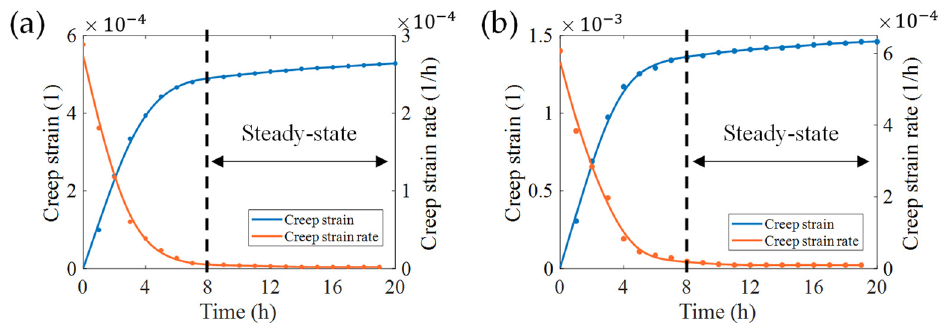
Figure 10. Creep and creep rate for a transverse surface profile ( a ) and side-wall profile ( b ) of sensitive grids. The creep curve is the same as the condition of B / T g = 8% shown in Figure 8b, A / W g = 8% shown in Figure 8c. The creep rate approaches to zero beyond 8